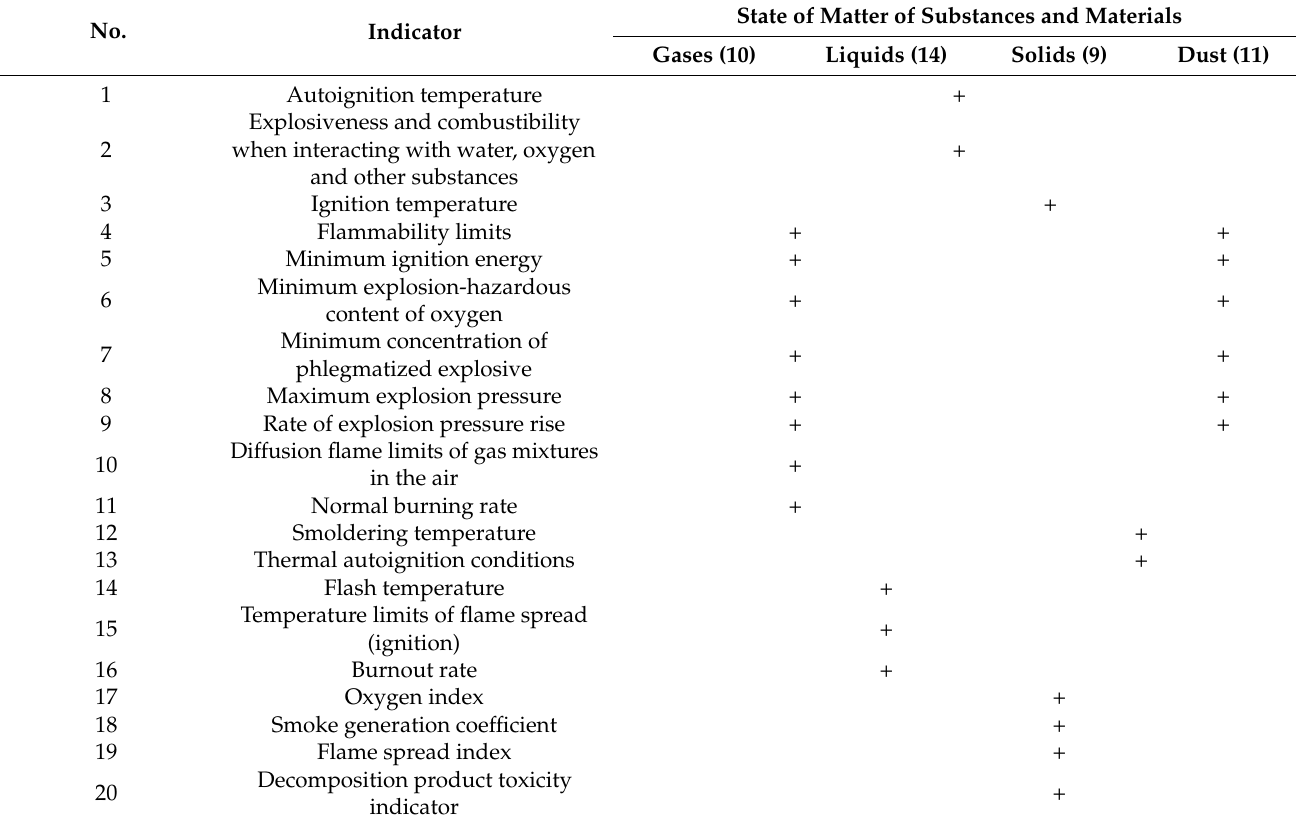
Table 1. Indicators of fire and explosion safety of substances and materials